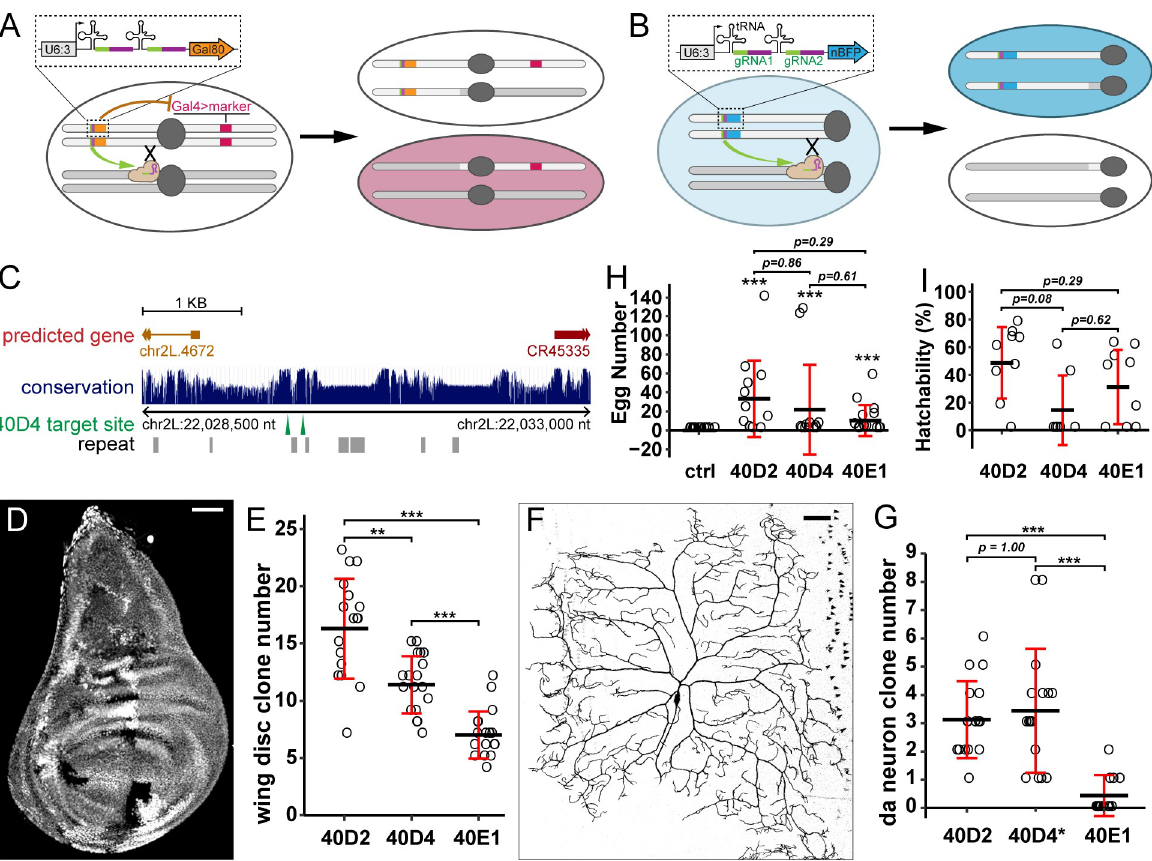
Fig 2. A toolkit for generating labeled clones for genes on chromosome arm 2L. (A) Strategy of pMAGIC for generating positively labeled clones for genes on 2L using Gal80. (B) Strategy of nMAGIC for genes on 2L using nuclear BFP marker. (C) A map for gRNA-(40D4) target sites derived from the UCSC Genome Browser. The height of the blue bar corresponds to the level of conservation among 23 Drosophila species. The locations of predicted genes (thick line, exon or mature RNA; thin line, intron; arrow, gene orientation), repeated DNA sequences (gray boxes), gRNA target sites (green arrowheads), and chromosomal coordinates are indicated. (D) A wing imaginal disc showing twin-spot clones generated by gRNA-40D2(nBFP) paired with hh-Cas9 . (E) Number of clones in wing discs using 3 different gRNA(nBFP) constructs. n = number of discs: 40D2 ( n = 17); 40D4 ( n = 18); 40E1 ( n = 18). �� p � 0.01, ��� p � 0.001; Welch ANOVA and Welch t tests, p -values corrected using Bonferroni method. (F) A C4da neuron clone generated by gRNA-40D2(Gal80) paired with SOP-Cas9 and ppk > CD4-tdTom . (G) Quantification of C4da clones using 3 different gRNA(Gal80) constructs. n = number of larvae: 40D2 ( n = 16); 40D4 ( n = 16); 40E1 ( n = 16). Clones were visualized by ppk > CD4-tdTom . ��� p � 0.001; Welch ANOVA and Welch t tests, p -values corrected using the Bonferroni method. The asterisk on 40D4 indicates frequent labeling of C3da clones. (H) Number of eggs produced by using ovo D1 (2L), nos-Cas9 , and 3 different gRNA(nBFP) constructs. The ctrl has no gRNA. n = number of females: ctrl ( n = 13); 40D2 ( n = 12); 40D4 ( n = 12); 40E1 ( n = 14). Asterisks are from post hoc single sample t tests that compare the EMM of each gRNA against the control ( μ = 0); ��� p � 0.001. p -Values are from contrasts of EMMs of each gRNA (excluding control). EMMs are based on a negative binomial model. All p -values were corrected using the Tukey method. (I) Hatchability of eggs produced by females carrying ovo D1 (2L), nos-Cas9 , and gRNA(nBFP) constructs. n = number of females: 40D2 ( n = 9); 40D4 ( n = 7); 40E1( n = 9). p -Values are from contrasts of EMMs of proportions of hatched/nonhatched eggs for each gRNA based on a binomial, mixed-effects model and were corrected using the Tukey method. For E, G, and H: black bar, mean; red bar, SD. Scale bars, 50 μ m. The data underlying this Figure can be found in S1 Data. BFP, blue fluorescent protein; ctrl, control; EMM, estimated marginal mean; gRNA, guide RNA; nBFP, nuclear blue fluorescent protein; nMAGIC, negative MAGIC; pMAGIC, positive MAGIC.